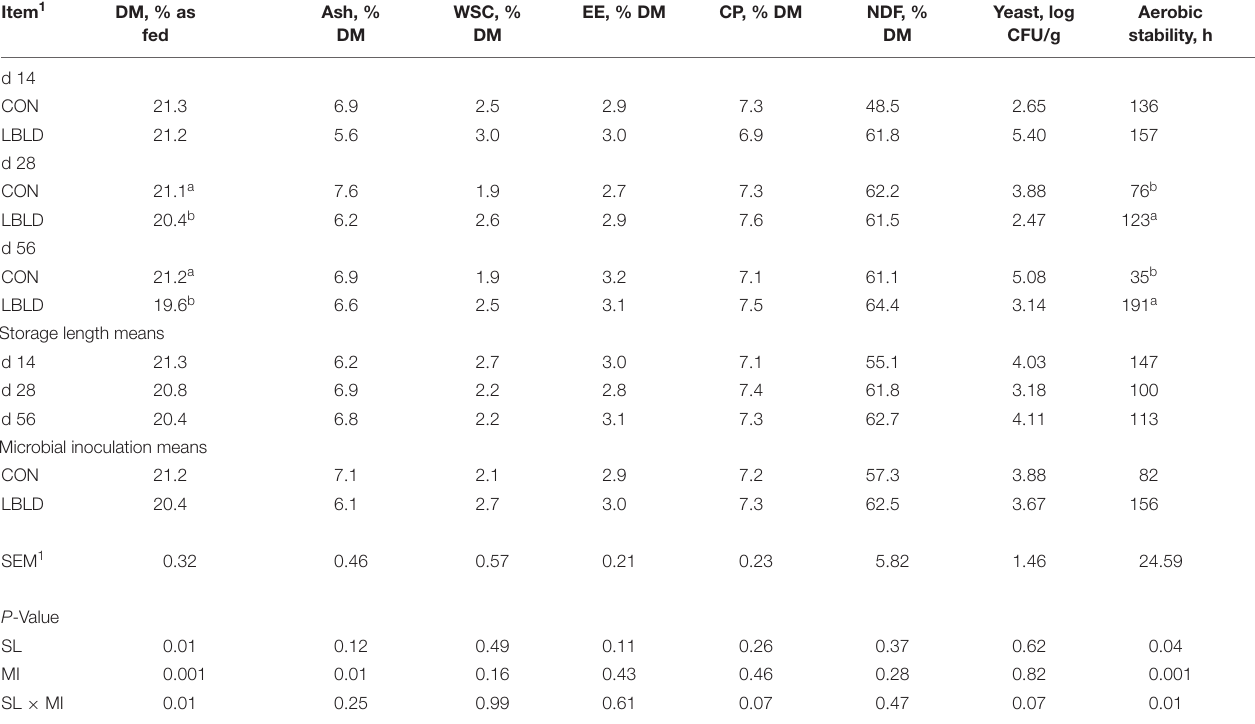
TABLE 3 | Effect of microbial inoculation and storage length on the nutrient composition, yeast counts, and aerobic stability of whole-plant sorghum silage in experiment